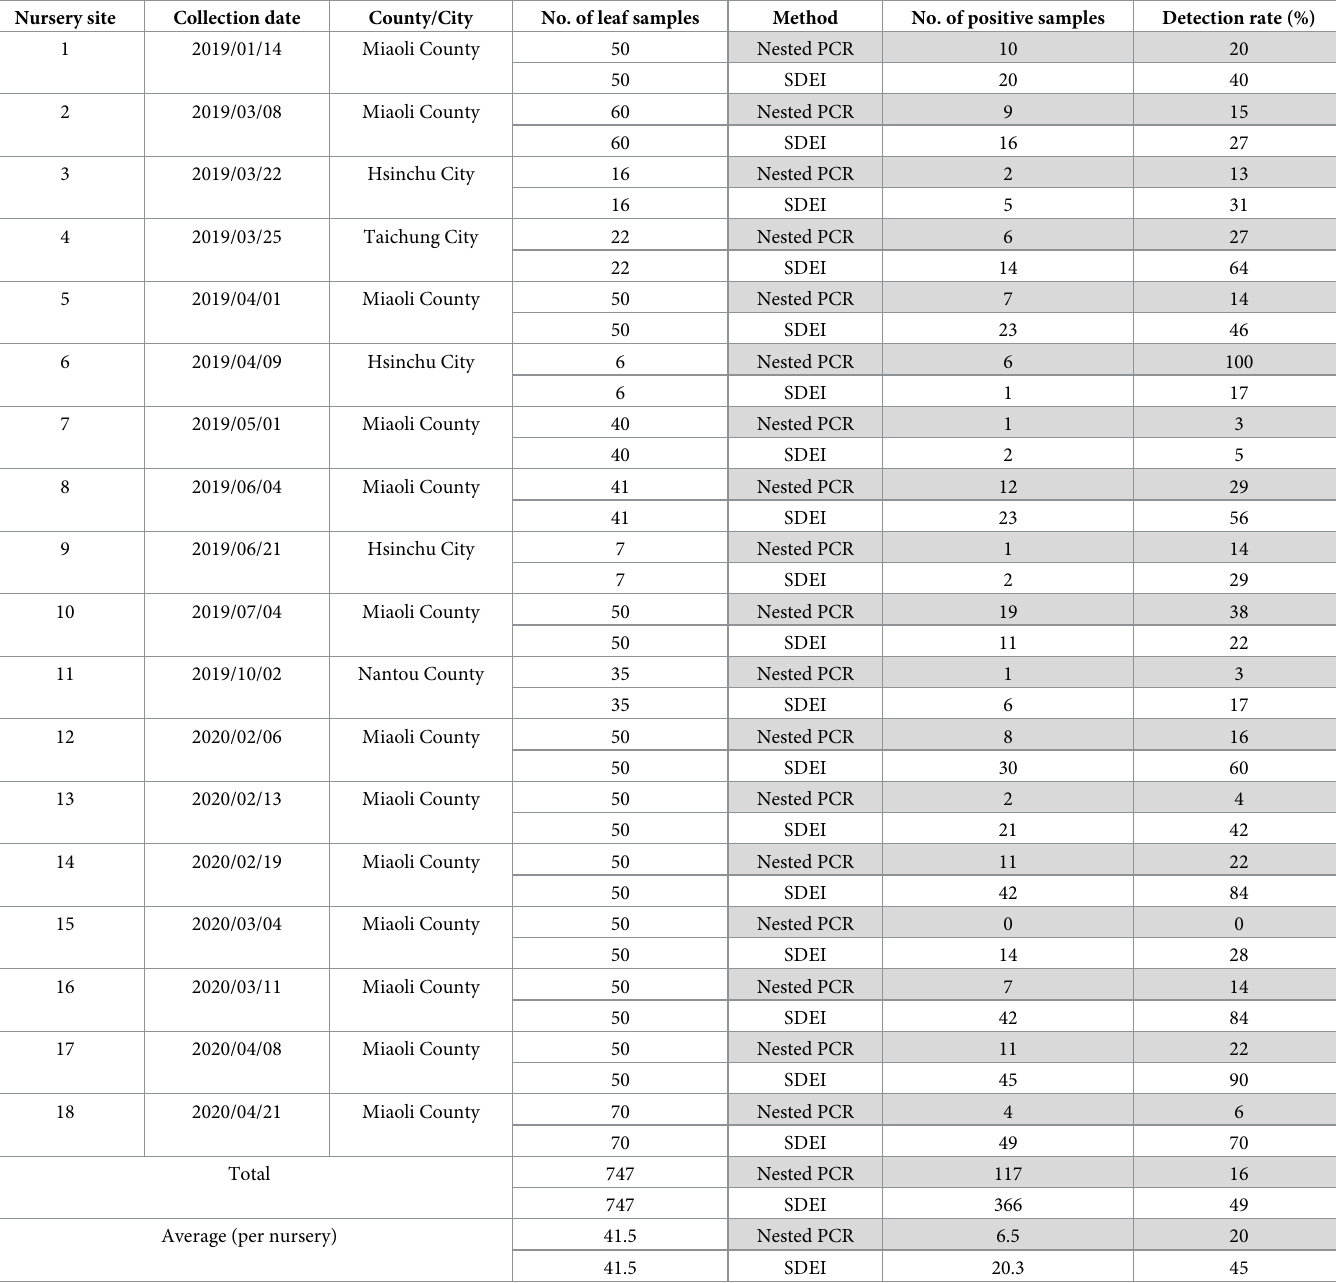
Table 2. Field survey of Colletotrichum spp. on symptomless strawberry plants using the nested PCR and SDEI (simple diagnosis by ethanol immersion) assays. Nursery